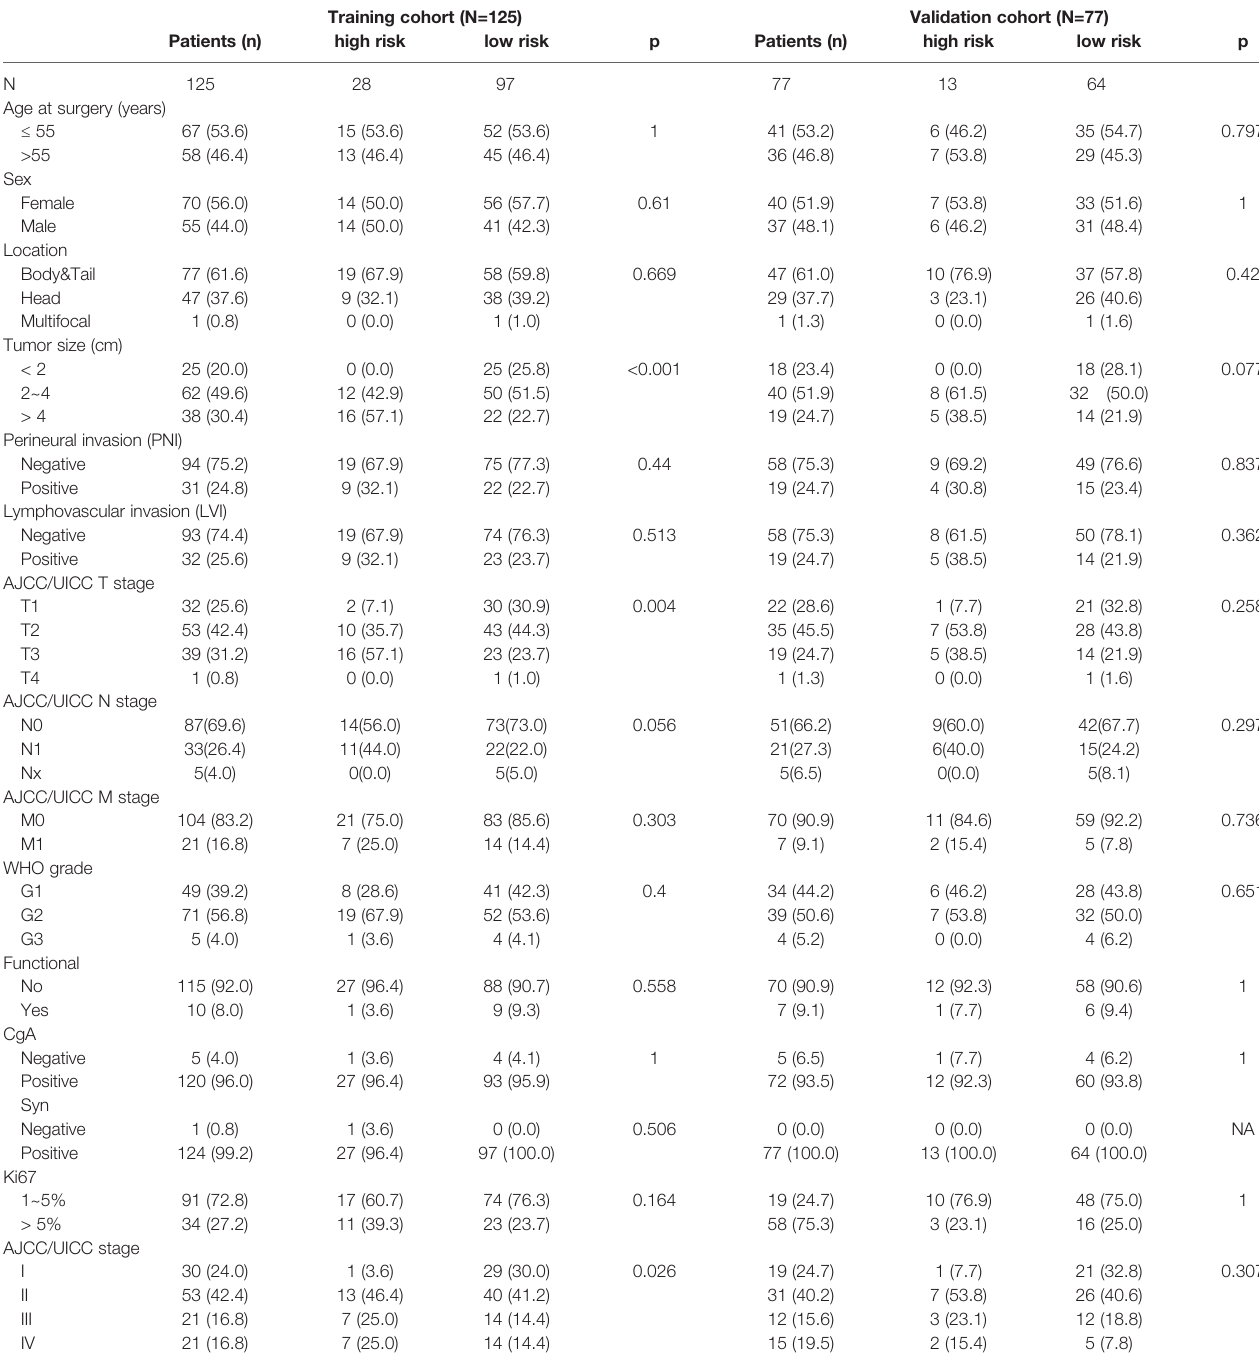
TABLE 1 | Clinical characteristics of patients in the training and external validation